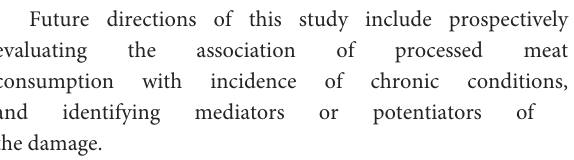
A B C D Prevalence Ratio (95% CI) † High High Low consumers consumers consumers with without with obesity obesity obesity n = 252 n = 317 n =